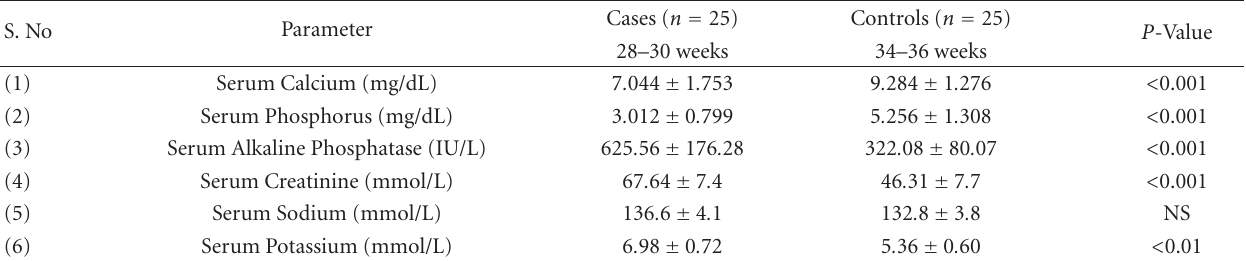
Table 1: Comparison of serum calcium, phosphorus, alkaline phosphatase, creatinine and electrolyte levels at 28–30 weeks and 34–36 weeks (Controls) of gestational age in preterm babies.